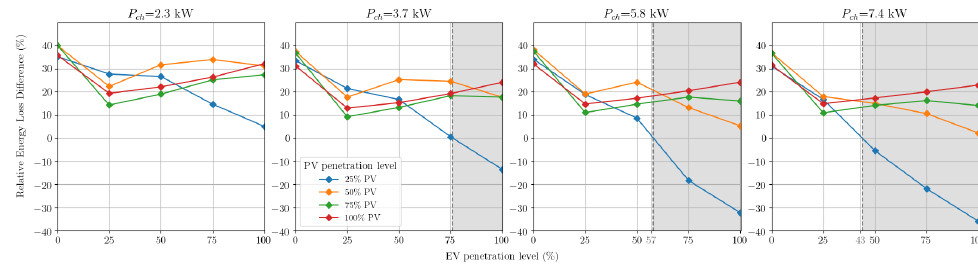
Figure 6. Comparison of the losses between the conventional approach and the proposed LVDC backbone for different charging rates, EV and PV penetration levels.